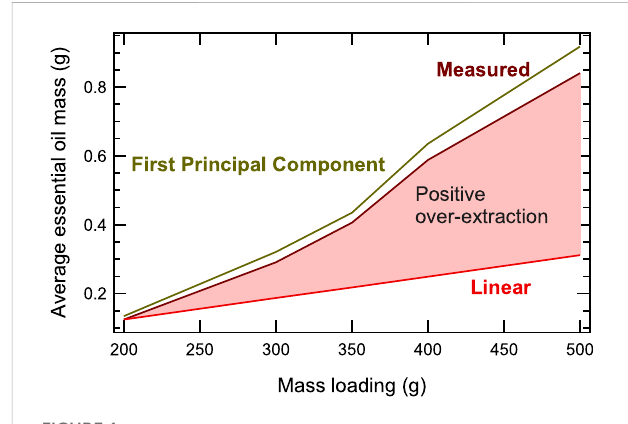
FIGURE 1 Extracted oil in terms of mass loading showing an extraction rate faster than expected. The extraction rate scales at a non-linear rate demonstrated by the fi rst principal component in a PCA